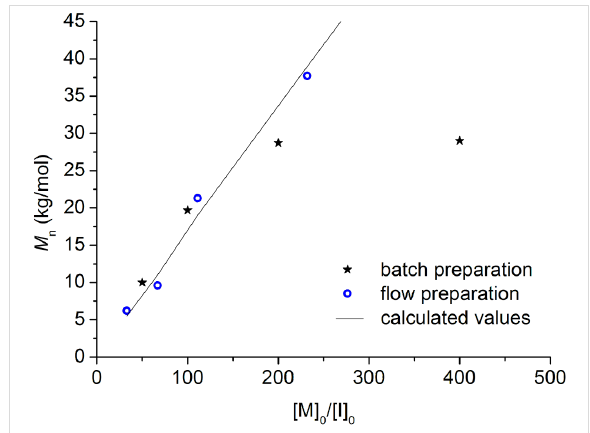
Figure 1: Plot of number-average molecular weight, M n , versus mono- mer–catalyst ratio [M] 0 /[I] 0 for batch and flow samples prepared by external initiation using Ni catalyst 3 (see Table 1 for experimental